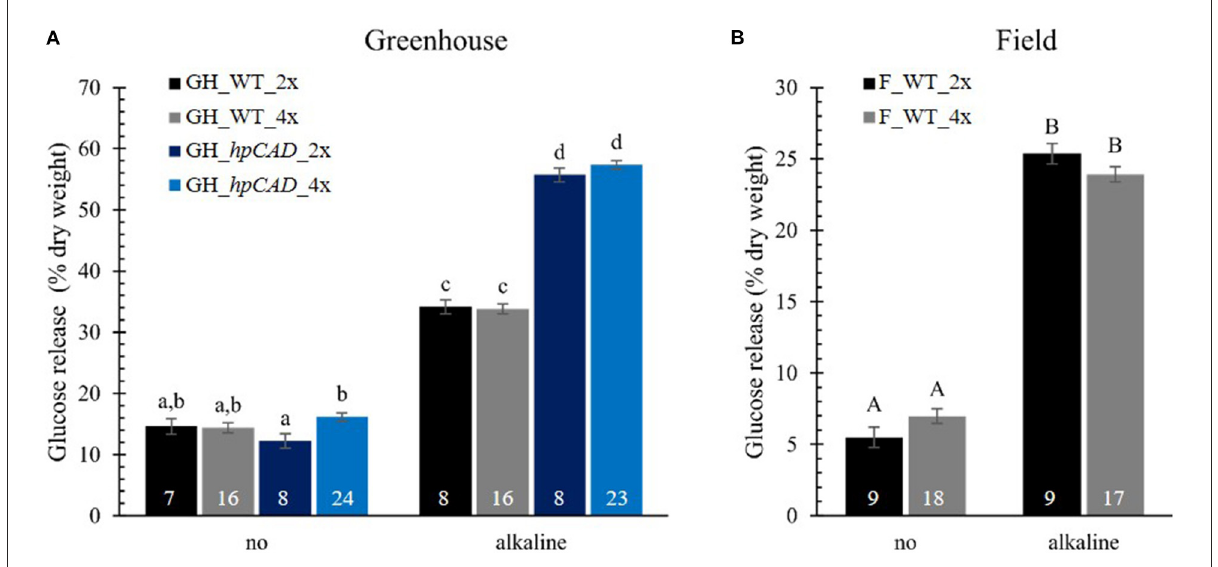
FIGURE5 Saccharification yield of di- and tetraploid poplar trees. Glucose release without (no) and with alkaline pretreatment was determined after 10h and expressed as % of dry weight. Data of greenhouse (GH)-grown (A) and field (F)-grown (B) poplars were collected in different experiments. The number of biological replicates is indicated in the bars. Data shown are adjusted mean ± standard error of the mean (SEM). Different letters represent significant differences at the 0.05 significance level. For a detailed description of the models fitted to the data and the statistical tests used, see Supplementary Materials and Methods